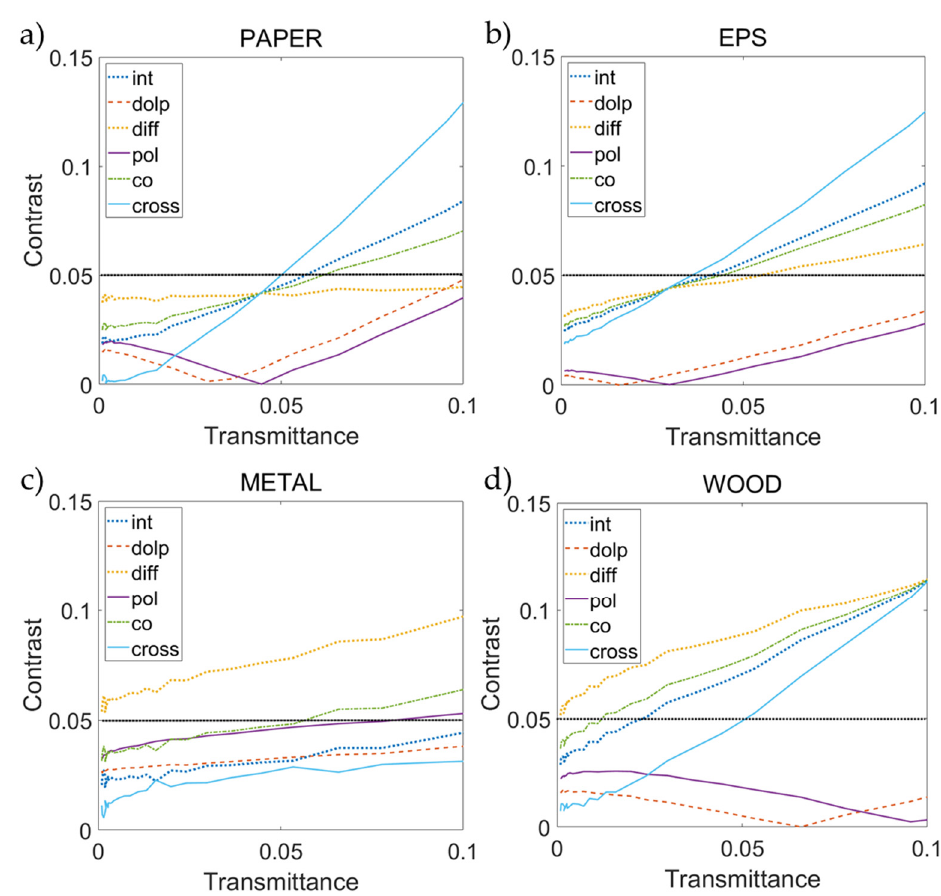
Figure 8. Michelson’s contrast obtained for the image modes described in Table 4, at different transmittances. Each subfigure shows the result for different materials: ( a ) paper, ( b ) EPS, ( c ) metal, and ( d ) wood. Black line marks the 5% contrast threshold.